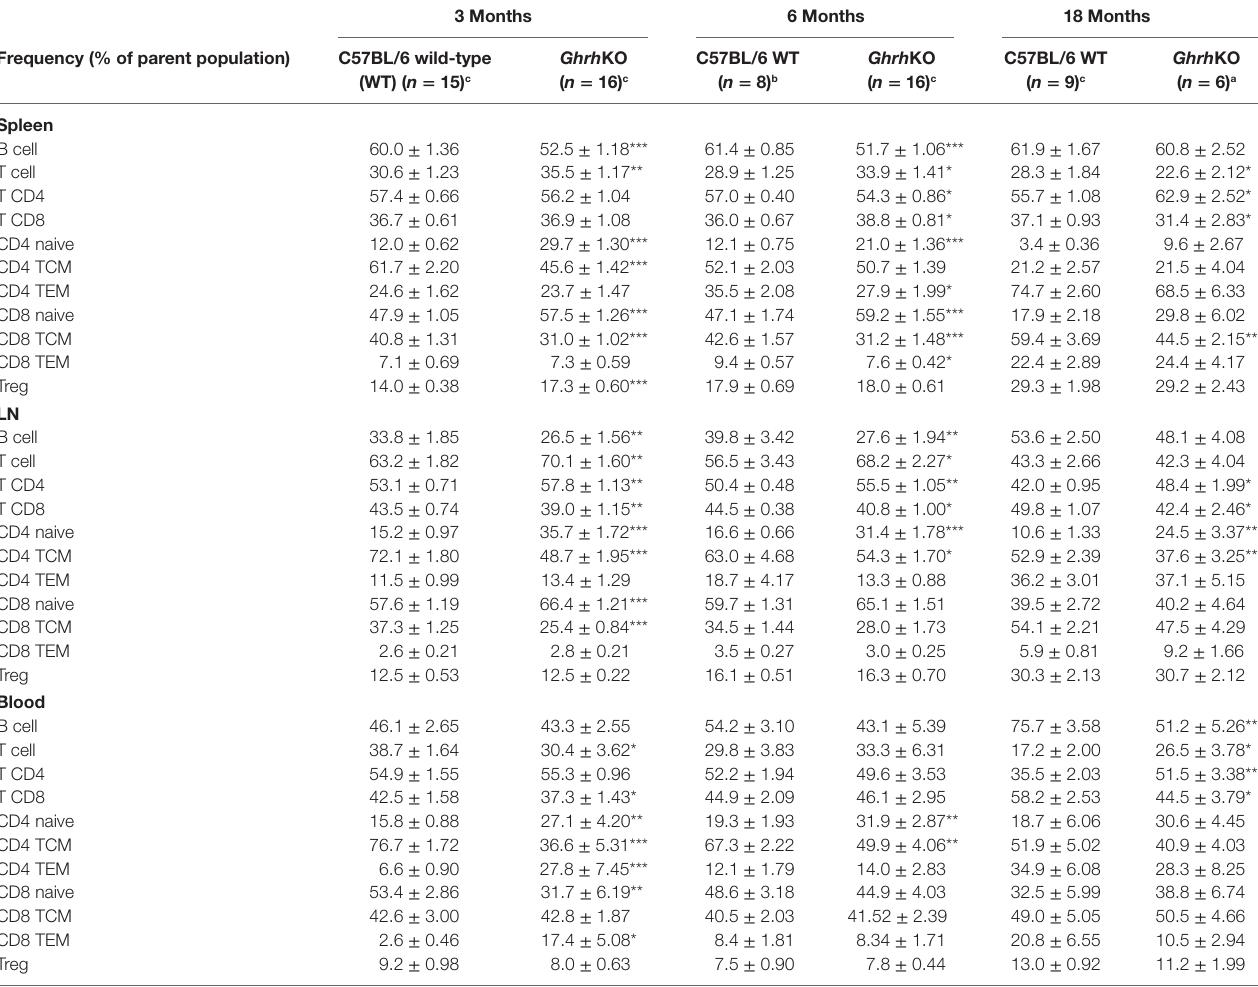
Data (mean ± SEM) are representative of one a , two, b or three c independent experiments. Values significantly different from age-matched WT mice ***p < 0.001, **p < 0.01, *p < 0.05. CD19 + B cells and CD3 + T cells are analyzed within the CD45 + population. T cell population is divided into CD4 + and CD8 + T cells. 20,000 CD45 + events are recorded. Naïve (CD44 low CD62L hi ), TCM (CD44 hi CD62L hi ), and TEM (CD44 hi CD62 low ) cells are analyzed within de CD3 + CD4 + or CD3 + CD8 + populations. FoxP3 + Treg cells are studied inside the CD4 + SP